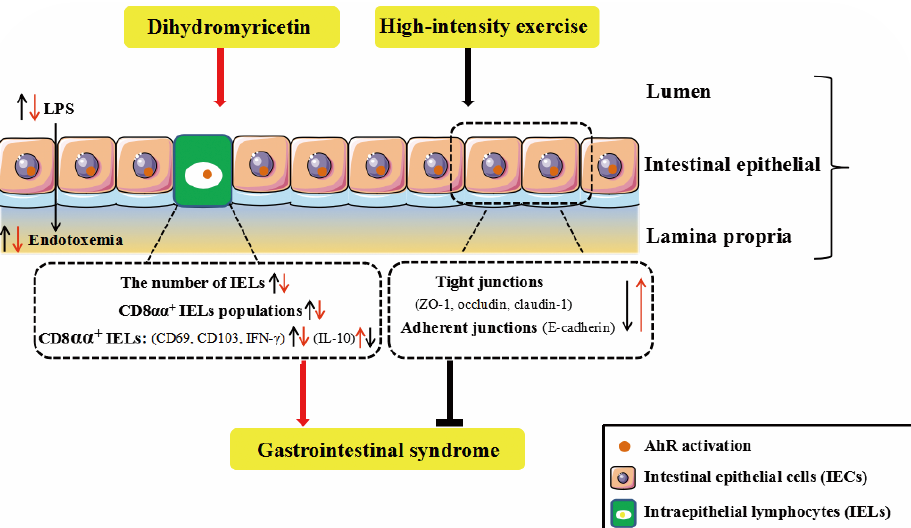
Figure 6. DHM attenuates HIE-induced intestinal barrier dysfunction associated with the modulation of the quantity and phenotype of IELs. The HIE induces an increased intestinal permeability and endotoxemia associated with impaired epithelial barrier, as indicated by the reduced expressions of TJ proteins, which could be ameliorated by DHM supplementation. Furthermore, DHM administration notably suppressed HIE-induced quantitative and phenotypic changes in IELs, particularly CD8 αα + IELs and the associated immune markers expression, which might be mediated through the activation of